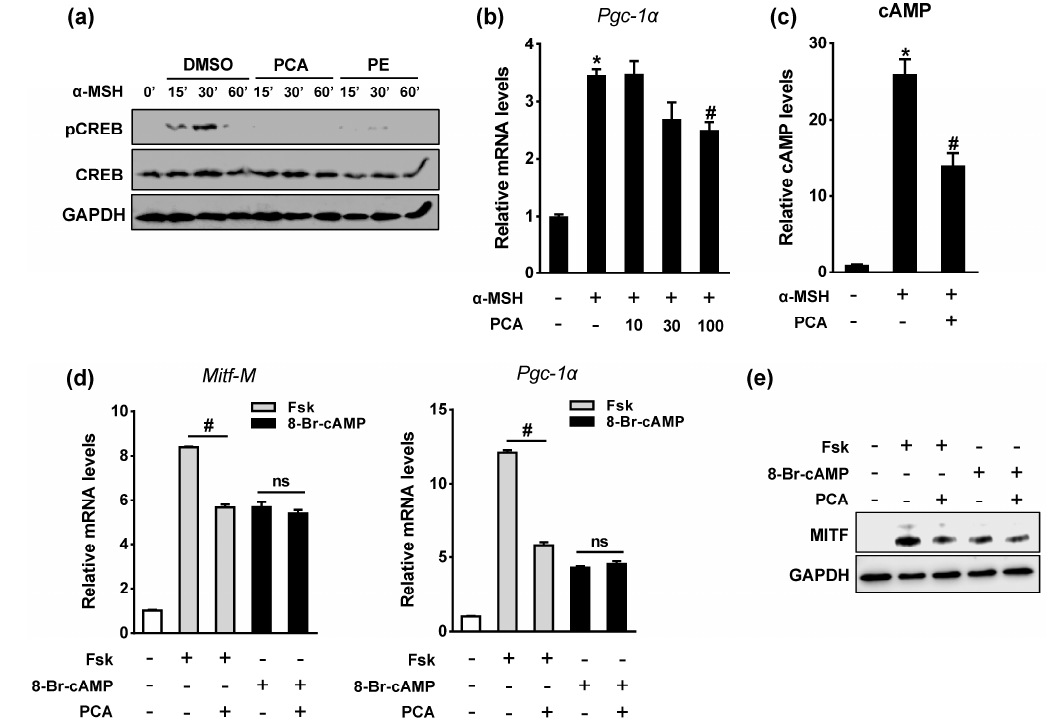
Figure 5. Effects of PCA on CREB phosphorylation and intracellular cAMP level. B16F10 cells were pretreated with 100 μ M PCA for 24 h prior to 1 μ M α -MSH treatment for indicated time. ( a ) Cell lysates were analyzed for pCREB, CREB, and GAPDH protein levels by immunoblotting; ( b ) mRNA levels for Pgc-1 α were analyzed by RT-qPCR. * p < 0.05 vs. control; # p < 0.05 vs. α -MSH; ( c ) Cells were pretreated with 100 μ M PCA for 24 h, and then exposed to 1 μ M α -MSH for 30 min. Intracellular cAMP concentration was measured by immunoassay as described in Materials and methods. * p < 0.05 vs. control; # p < 0.05 vs. α -MSH; ( d ) Cells were exposed to 20 μ M forskolin (Fsk) or 100 μ M 8-Br-cAMP in presence or absence of PCA (100 μ M) for 24 h. mRNA levels for Mitf-M and Pgc-1 α . # p < 0.05 vs. Fsk; ns, not significant. Data are mean ± SEM; n = 3; ( e ) Protein level for MITF.